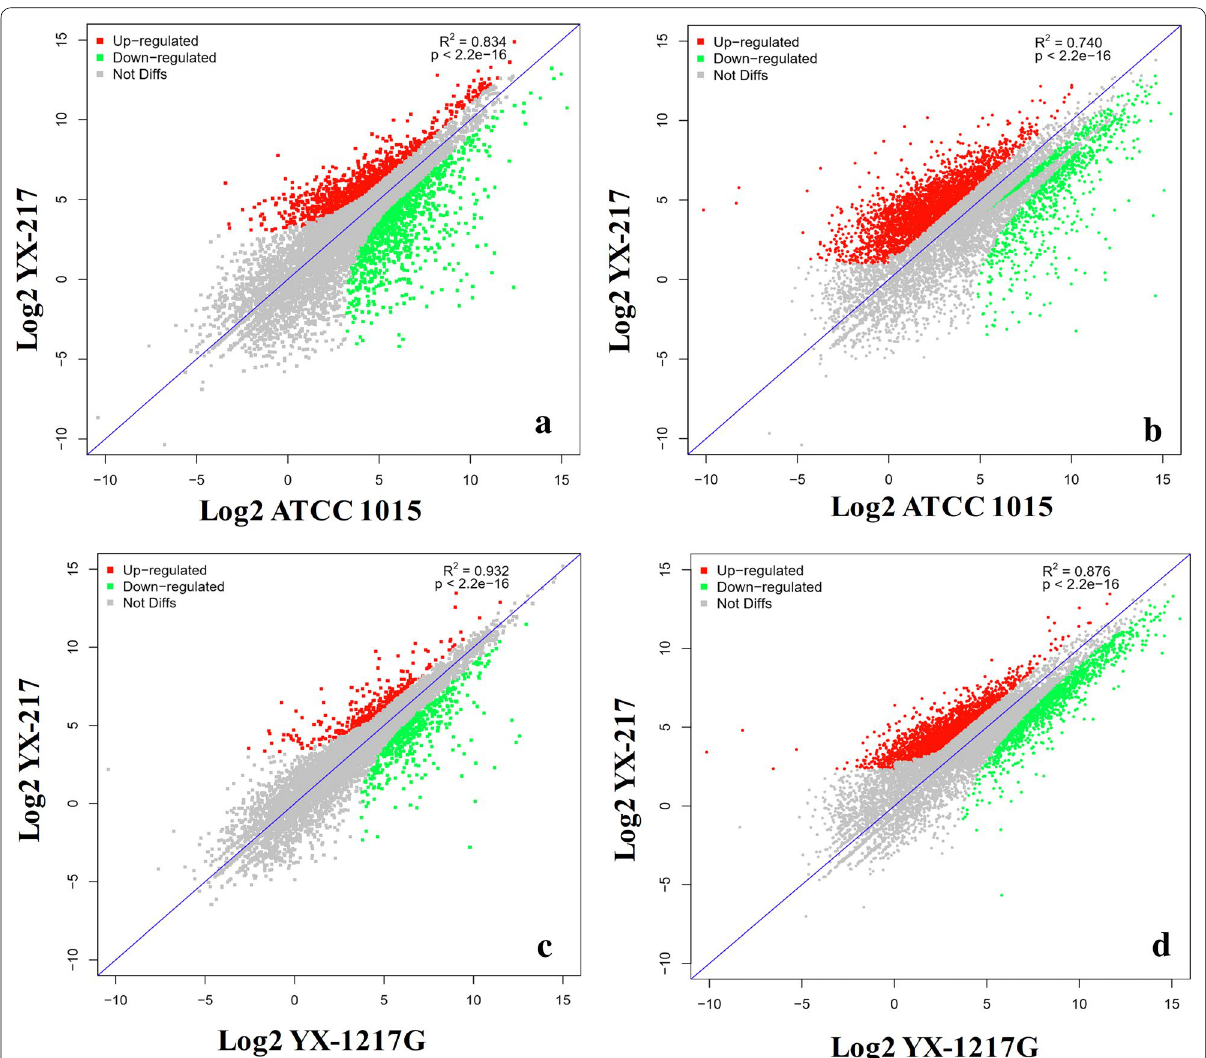
Fig. 2 Scatter plots of gene expression levels across different samples. a The transcriptional differences between A. niger YX‑1217 and ATCC 1015 ( S 1/ S 3) at the stage of 10 h; b the transcriptional differences between A. niger YX‑1217 and ATCC 1015 ( S 1/ S 3) at the stage of 40 h; c the transcrip‑ tional differences between A. niger YX‑1217 and A. niger YX‑1217G ( S 1/ S 2) at the stage of 10 h; d the transcriptional differences between A. niger YX‑1217 and A. niger YX‑1217G ( S 1/ S 2) at the stage of 40